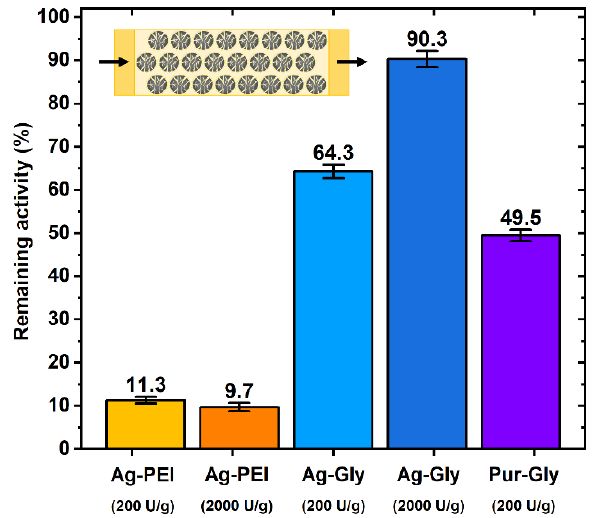
Figure 9. Remaining activity of biocatalysts used in the hydrolysis of cellobiose in continuous operation. In the case of the Pur ‐ Gly biocatalyst, due to the aforementioned adsorption problems, was measured with a dilution of 5 mM pNPG in 100 mM sodium citrate buffer 100 mM pH 5.0 with 30% ethanol to minimize hydrophobic interactions between the matrix and the pNP. The results obtained in the charac ‐ terization in terms of activity are not valid to this problem of adsorption (Table 1, Section 2.1).